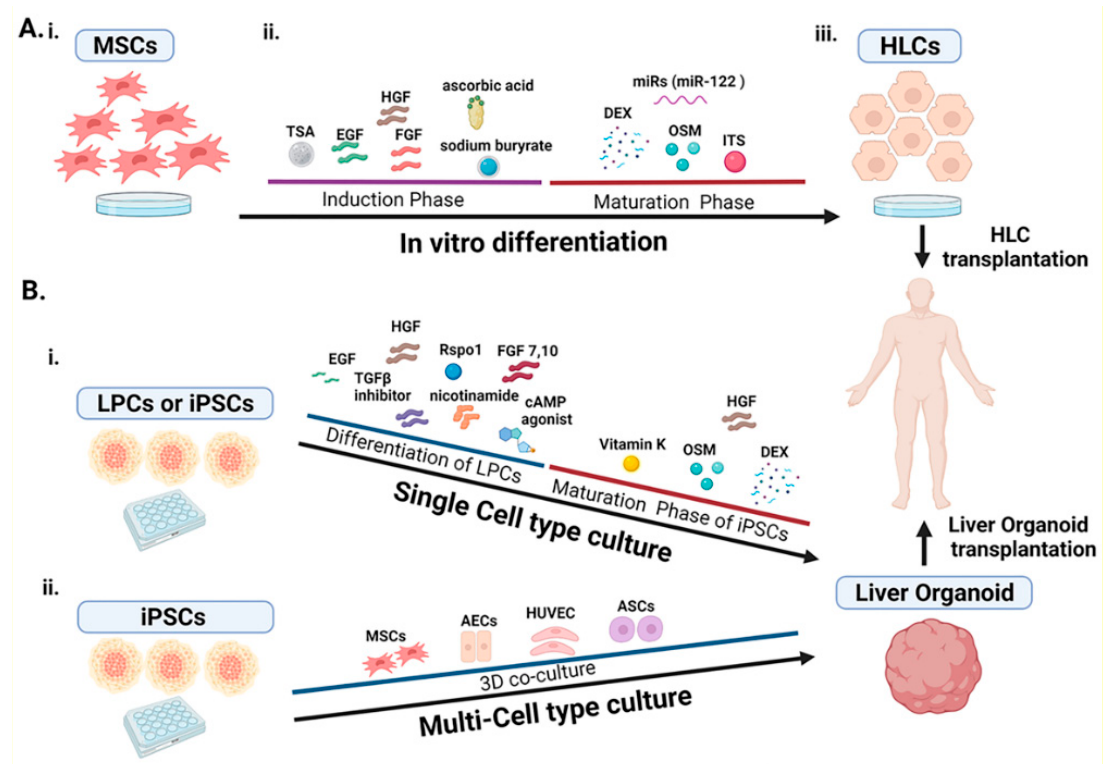
Figure 1. Generation of MSC-derived HLCs and liver organoids from iPSCs or LPCs for transplan- tation in patients with liver diseases. ( A ). In vitro ( i ) culture and ( ii ) differentiation of MSC into HPLCs. The differentiation process is divided into the induction and maturation phases with the addition of growth factors, molecules or miRs. ( iii ) The derived HLCs can be used for transplantation. ( B ). Generation of liver organoids from different cell types. ( i ) Single cell-type differentiation of LPCs in presence of growth factors and molecules and maturation of iPSCs in presence of several compounds that lead to liver organoid formation. ( ii ) Multi-cell-type culture of iPSCs with other cell types for liver organoid formation. The 3D co-culture of iPSCs with a variety of cell types enhances the liver organoid formation for transplantation in patients with liver diseases. MSCs, mesenchymal stromal cells; HLCs, hepatocyte-like cells; TSA, trichostatin; EGF, epidermal growth factor; HGF, hepatic growth factor; miR; micro-RNAs; DEX; dexamethasone; OSM, oncostatin M; ITS, insulin-transferin-sodium selenite; LPCs, liver progenitor cells; TGF β , transforming growth factor β ; Rspo1, R-spondin 1; FGF, fibroblast growth factor; cAMP, cyclic adenosine monophosphate; AECs, amniotic epithelial cells; HUVEC, human umbilical vein endothelial cells; ASCs, amniotic stem cells. (Created by Biorender.com., 30 March 2022).